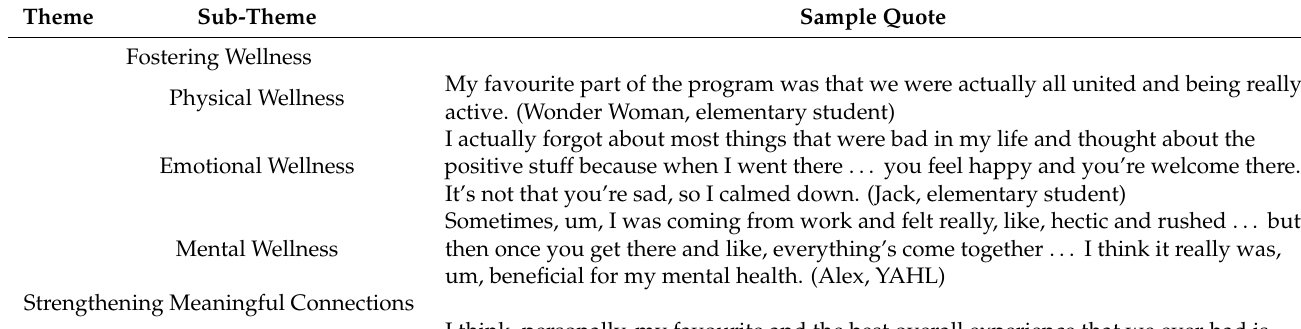
Table 1. List of Themes and Sub-themes with Sample